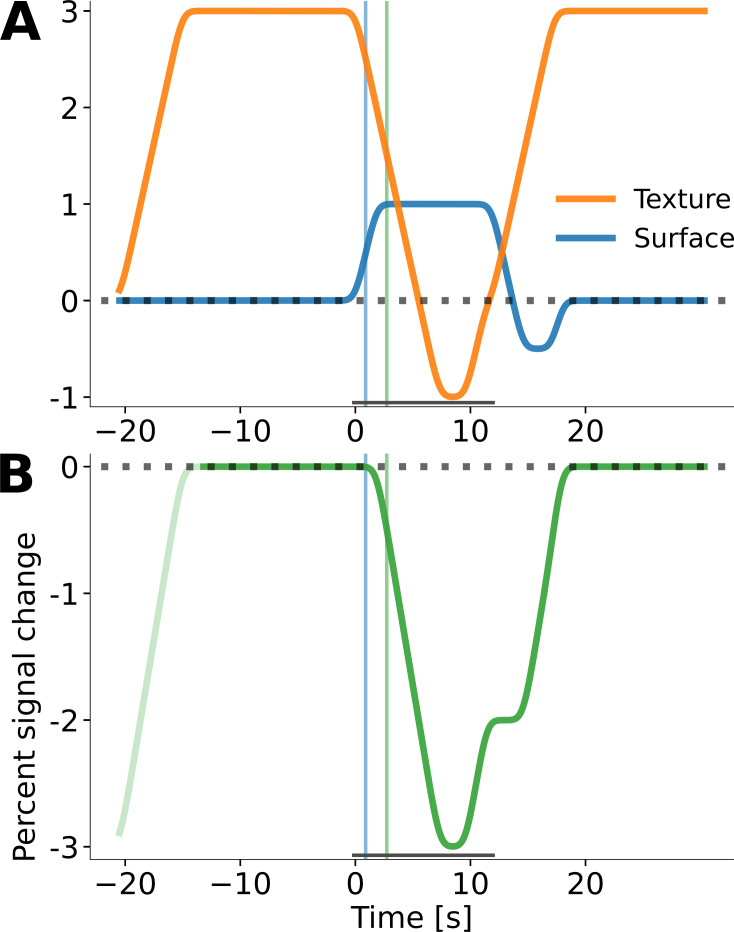
Simulation of negative fMRI response at the cortical representation of the stimulus centre.The observed negative response (Figures 5,6) might be the result of an elevated baseline. A control experiment showed that the full screen texture background causes a strong positive response, relative to a uniform background (response amplitude circa 3%; Figure 7—figure supplement 1). The horizontal grey bar indicates the duration of the surface stimulus in the simulation. The orange line in (A) represents this positive texture response (corresponding to Figure 7—figure supplement 1C). Another control experiment demonstrated that a uniform grey surface stimulus results in a positive response, relative to a dark uniform background (response amplitude circa 1%, Figure 6A, orange and red lines therein). This positive surface response is represented by the blue timecourse in (A). In the main experiment (Figures 5,6), a positive response to the texture background and a positive response to the grey surface stimulus might have had the same onset time. This is illustrated in (B), where the texture and surface responses from (A) are added, and the pre-stimulus interval is taken as a baseline with amplitude zero. The time point at which the composite negative response in (B) reaches –0.5% is indicated by the thin, vertical green lines. For comparison, the timepoint at which the surface response has reached its peak amplitude of 0.5% is indicated by the thin, vertical, blue lines. The simulated composite response resembles the empirically observed negative response in Figure 6A (green and blue lines therein).